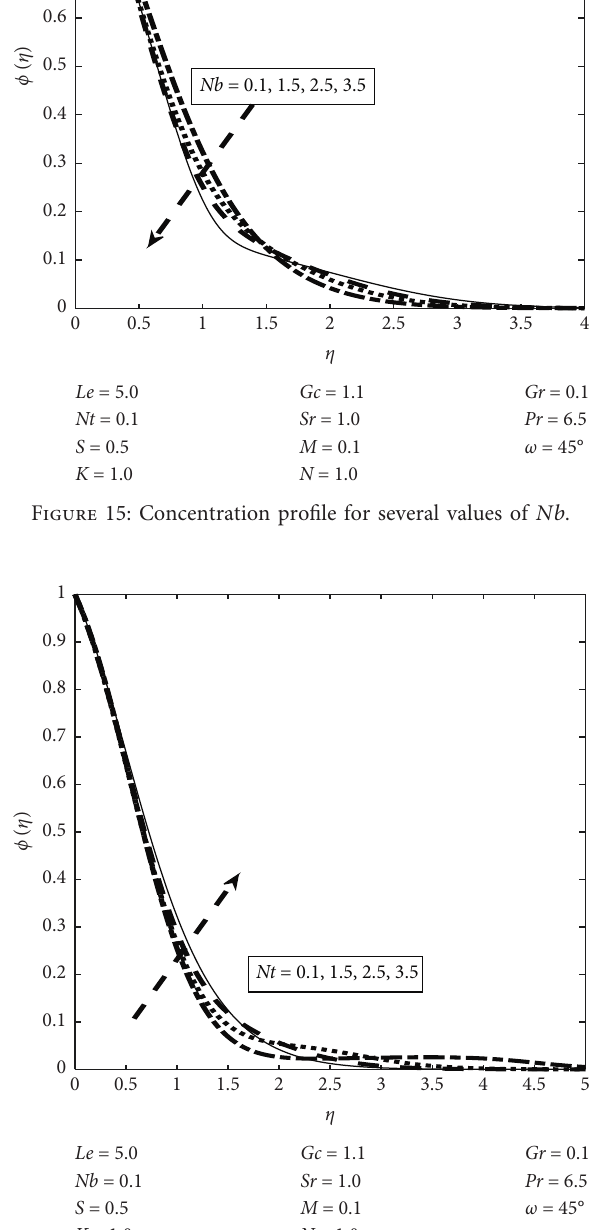
Figure 14: Concentration profile for several values of M .